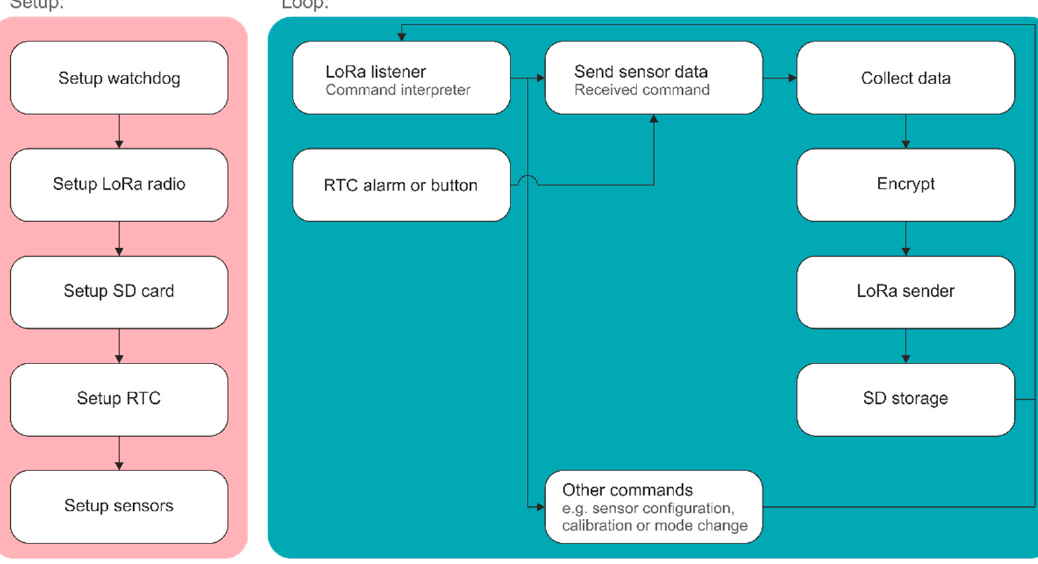
Figure 6. The architecture of the code in the node. Additional functionalities can be implemented by defining additional commands that trigger alternative workflows.